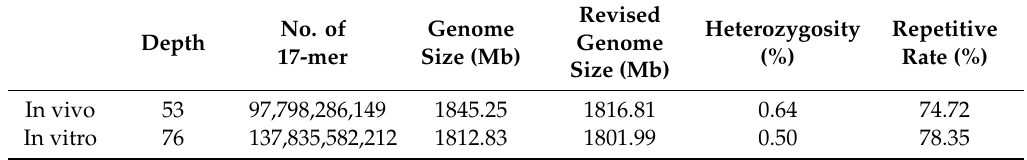
Table 5. Statistics of 17–mer analysis for genome size estimation of M.